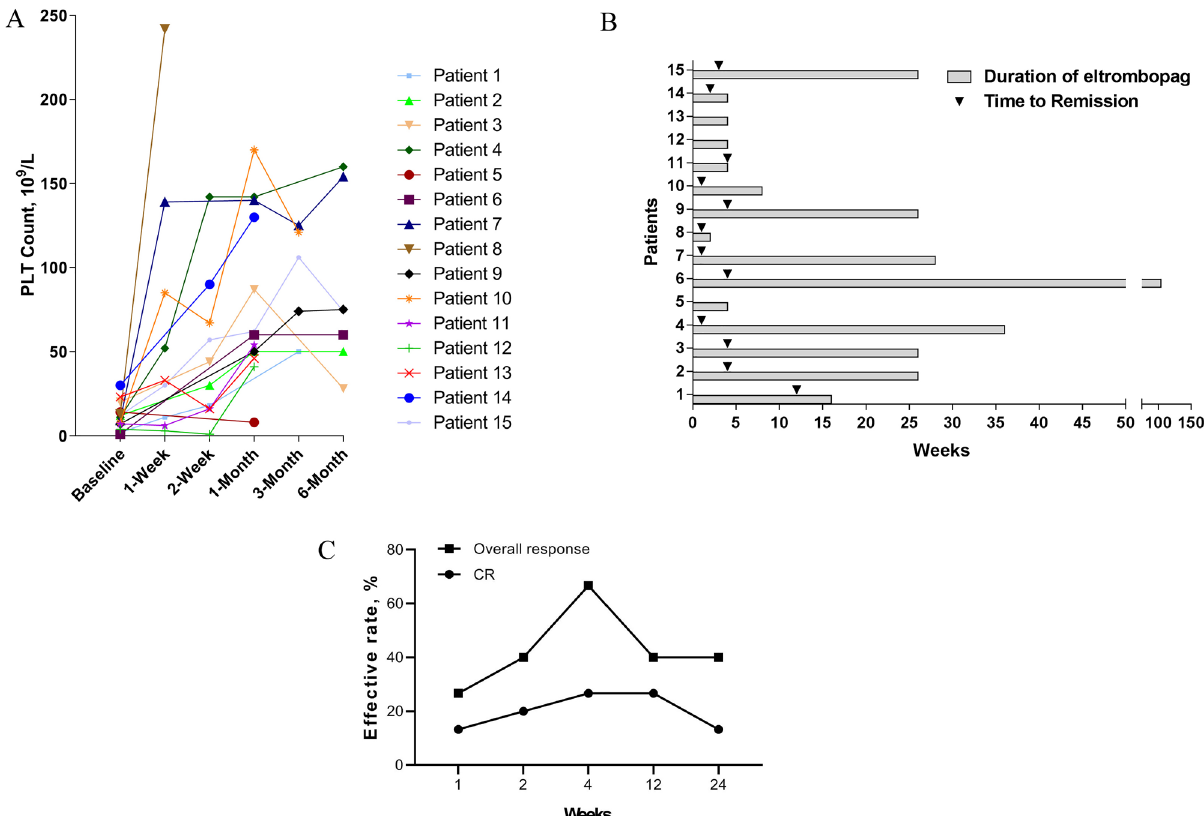
Figure 1. ( A ) The baseline platelet counts before treatment and platelet counts change curves at each time point during treatment with eltrombopag. ( B ) Total duration of treatment and time taken for response to therapy until August 2019. ( C ) The complete remission (CR) rate and overall response rate at each point during treatment with